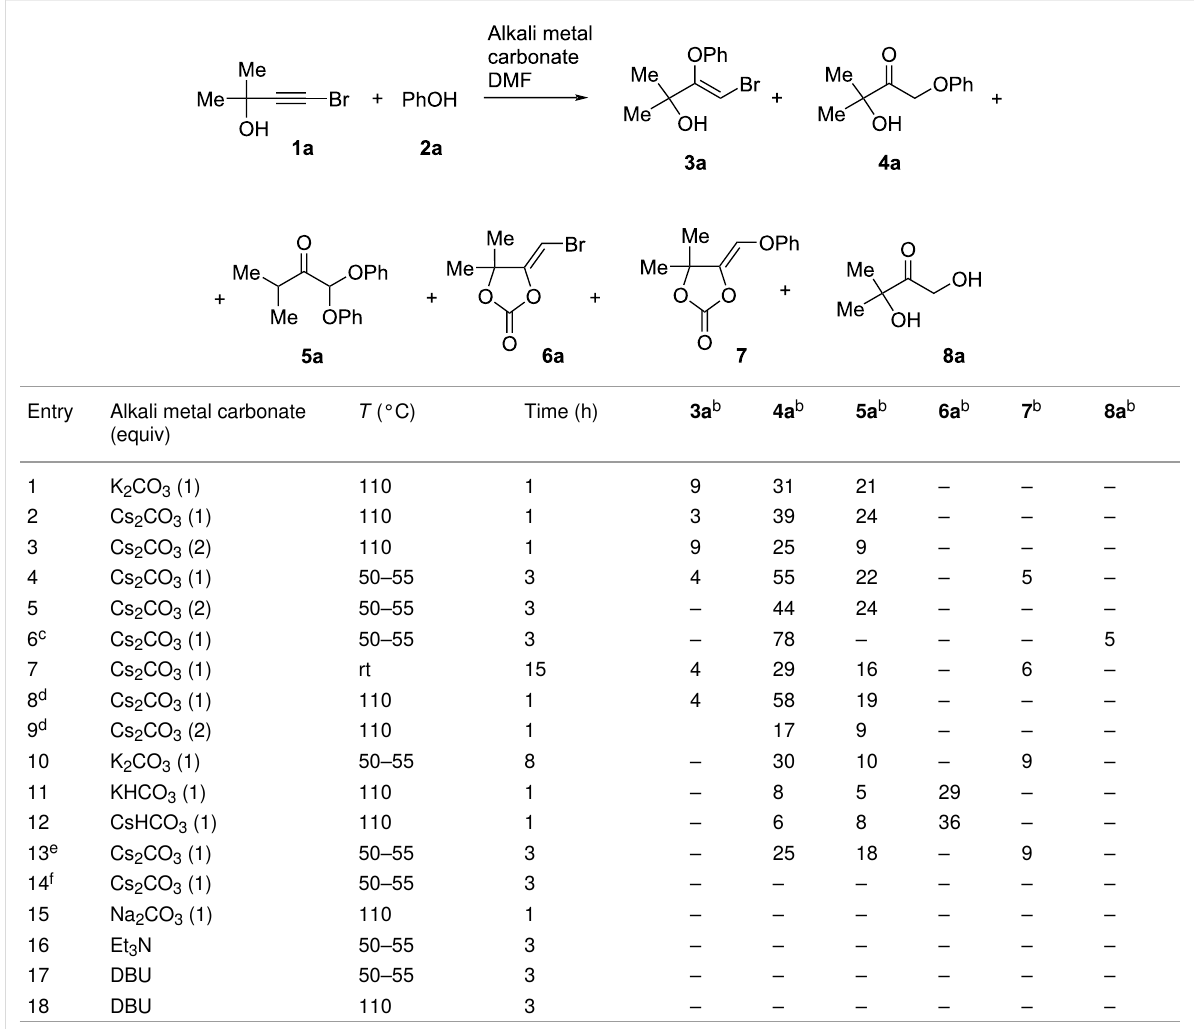
Table 1: Screening of the conditions for reaction of bromopropargylic alcohol 1a and phenol ( 2a ) a